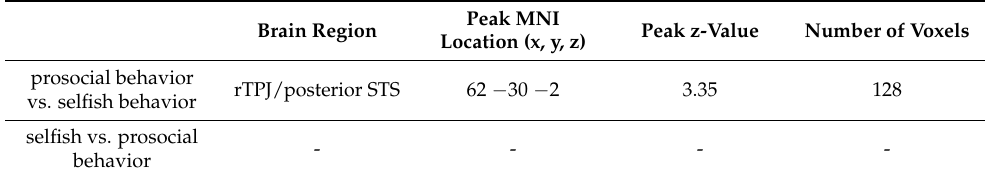
Table 3. Results of the contrast of brain responses during prosocial relative to selfish acting ( p < 0.05, Figure 3. Statistical maps showing brain activation for trials with social relative to non-social decisions. ( A ): Areas of FWE corrected). significant fMRI signal change are shown as color overlays on the T1-MNI reference brain (at p < 0.005, uncorrected, for picture purpose only). ( B ): Glass brain depicting same contrast as in A (at p < 0.005, uncorrected). Even at the very lenient threshold of p < 0.005 (uncorrected) we found no anterior insula activation.